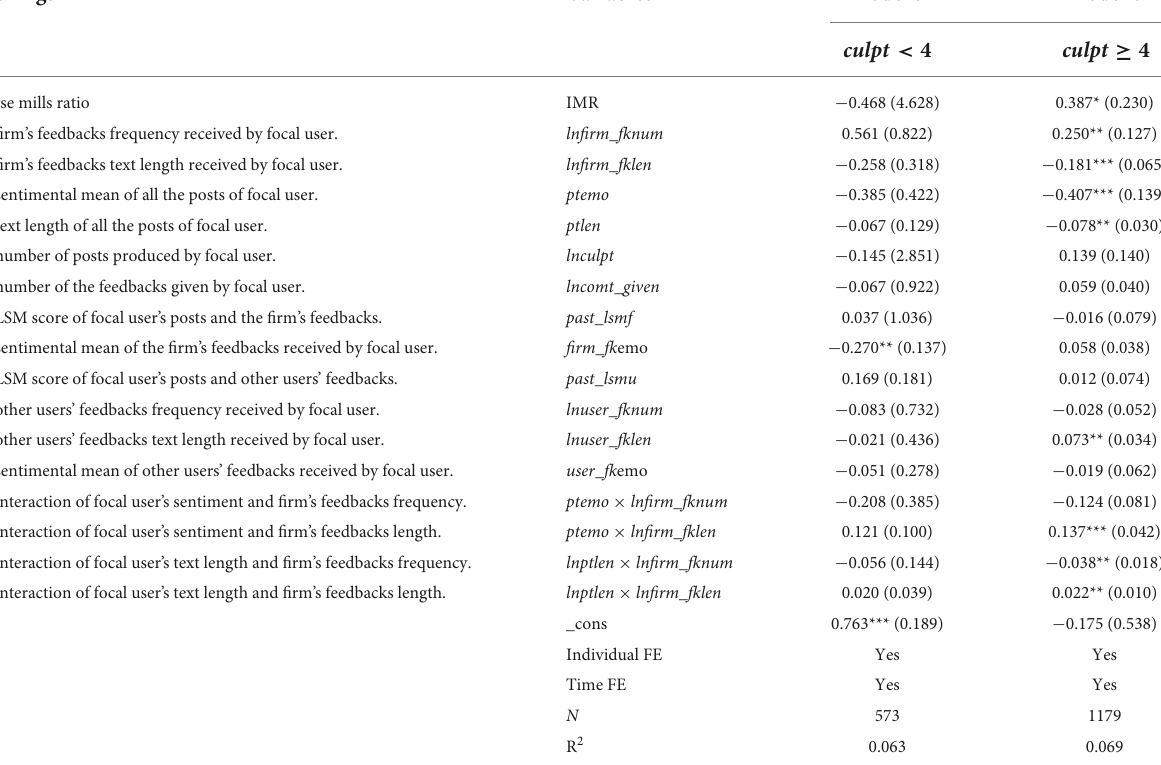
TABLE 4 Results of heterogeneity